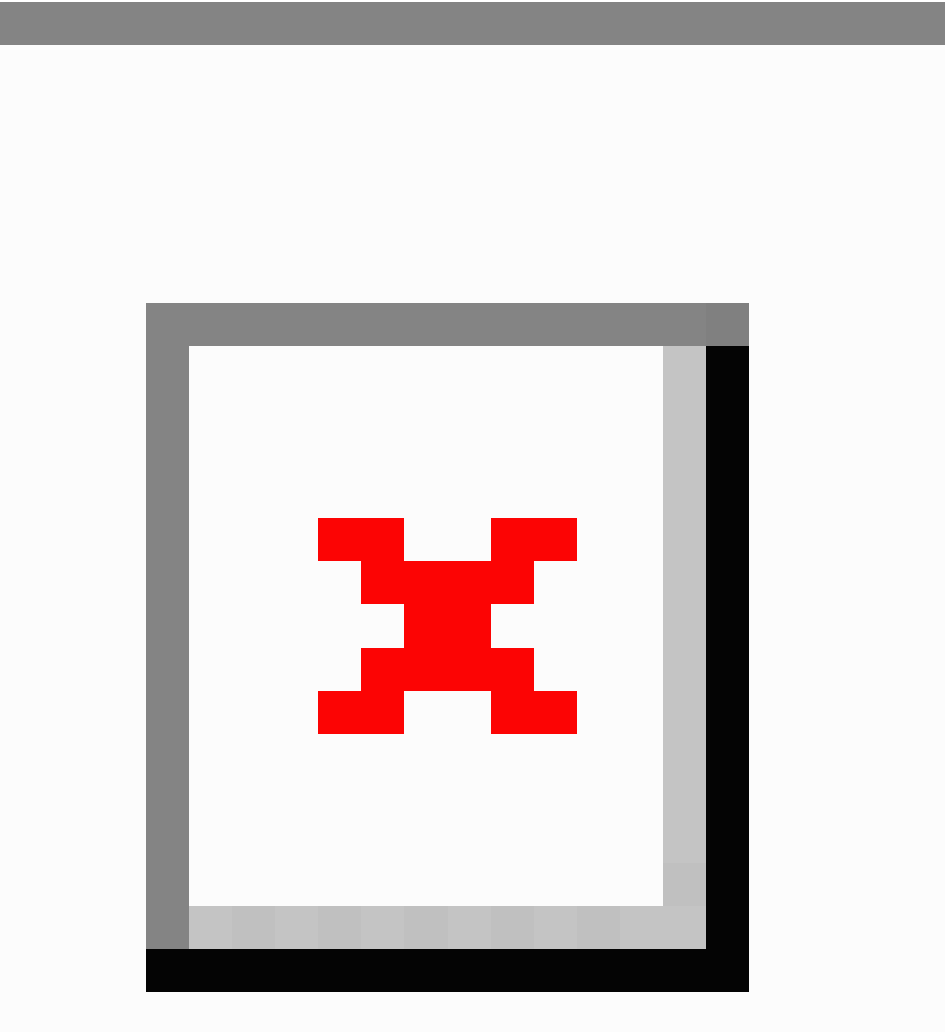
Figure 4. Arbitrary classification of functionality based on prevalence in the surveyed mobile applications (BP = blood pressure; PHR = personal health